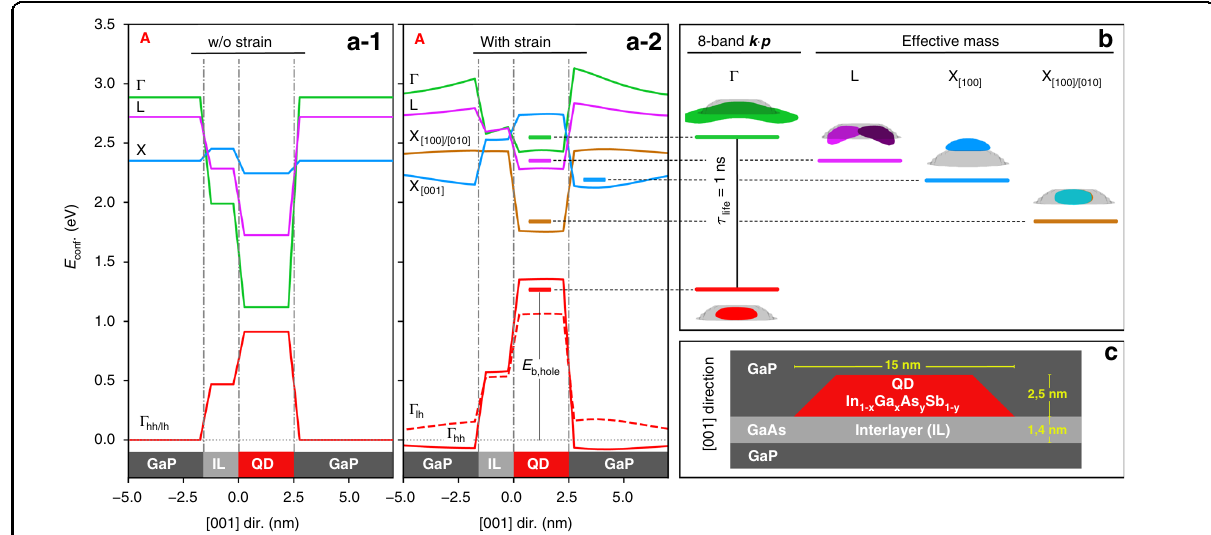
Fig. 8 a This shows unstrained (a-1) and strained (a-2) energies of Γ , L, X [001] , X [100]/[010] bands for electrons and holes in QD with Ga and As content being both equal to 20%. The ground-state energies are shown by thick horizontal curves and correspond to side cuts of the envelope functions ’ probability densities given in b . The modeled QD was truncated cone, with height and base (top) diameter of 2.5 nm, and 15 nm (8 nm), respectively. Below QDs we considered a interlayer of pure GaAs with thickness of 5 ML. c The whole structure was fi nally de fi ned in surrounding GaP